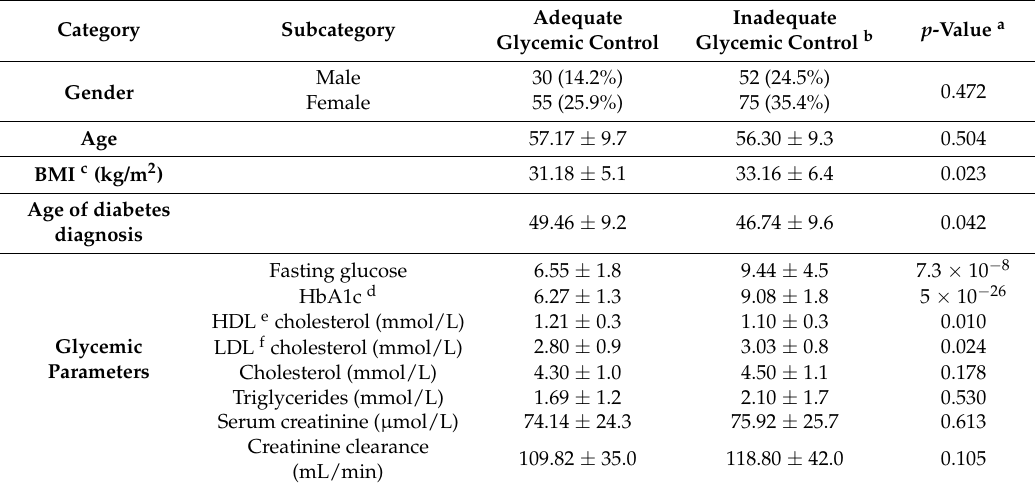
Table 2. Clinical characteristics of Jordanian patients with